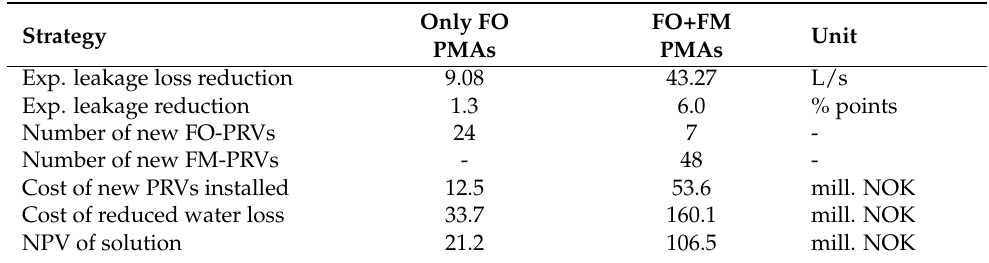
Table 3. NPV results for case considering only FO PMAs and considering combination of FO and FM PMAs (FO+FM PMA).